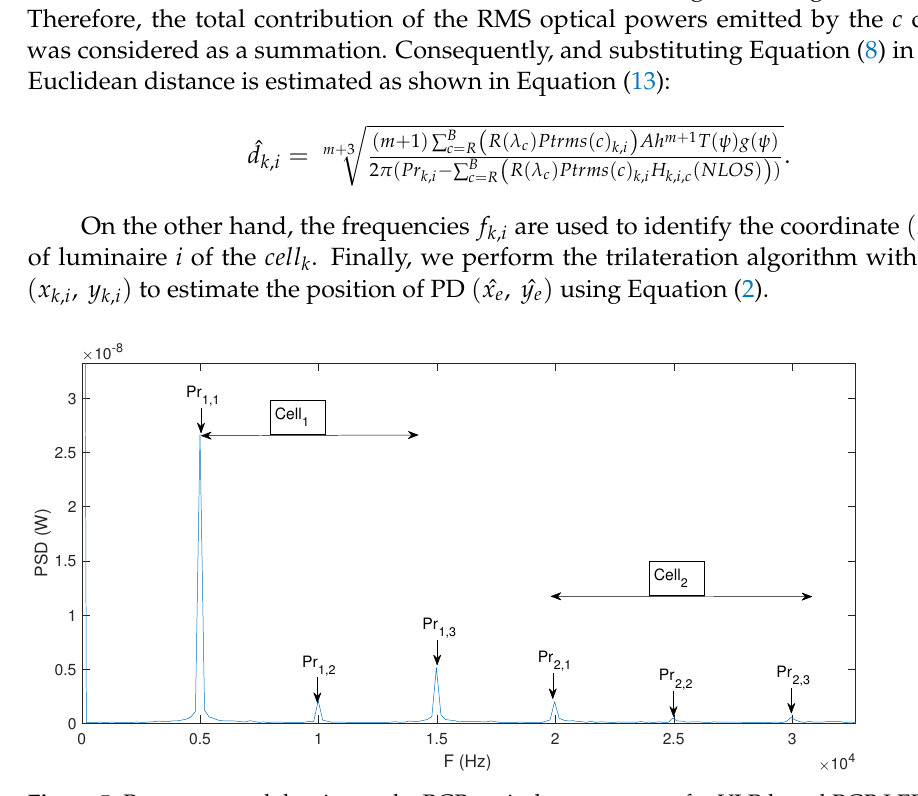
Figure 5. Power spectral density on the RGB optical power vector for VLP-based RGB